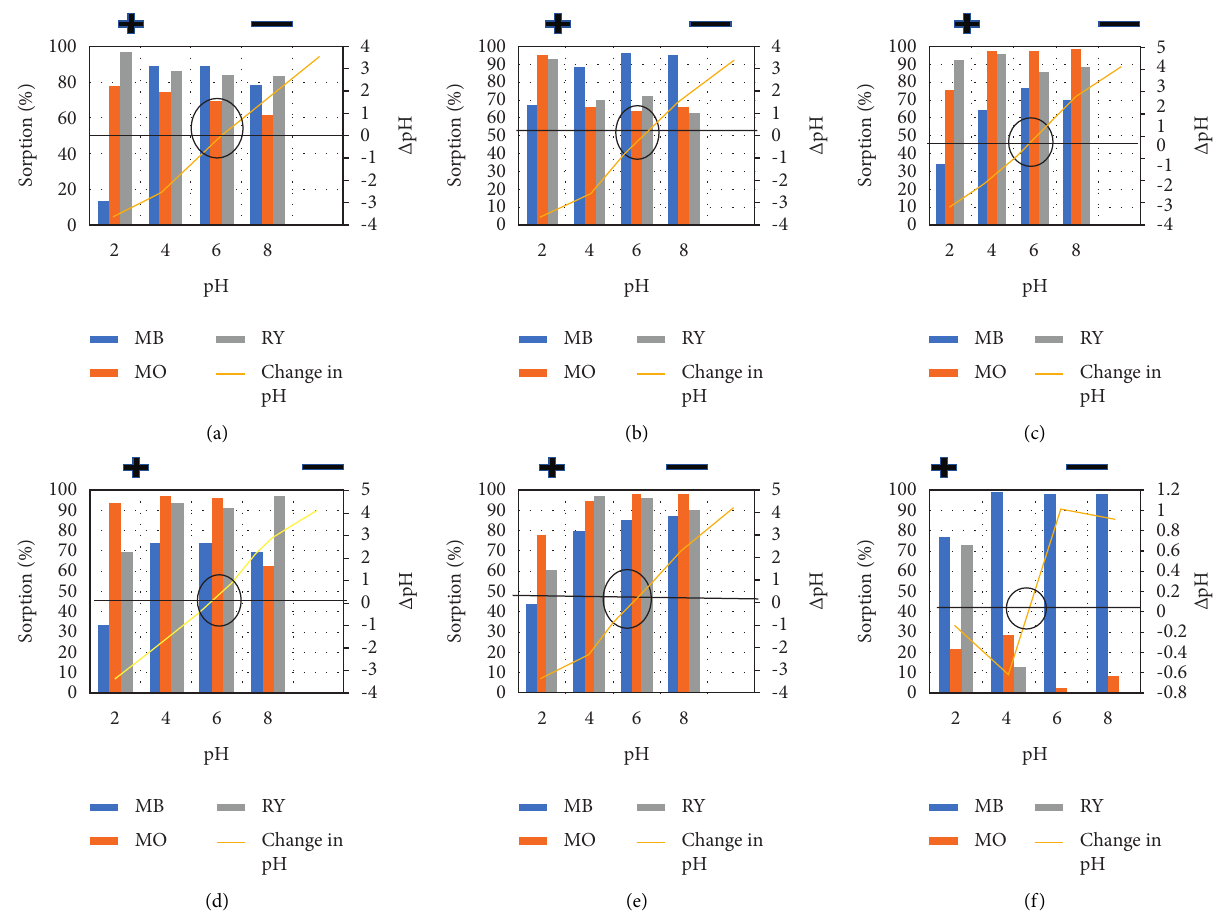
Figure 8: Point of zero charge plots and adsorption behavior of various materials for selected dyes. LDH (a), C-1 to C-4 (c–d), and HC